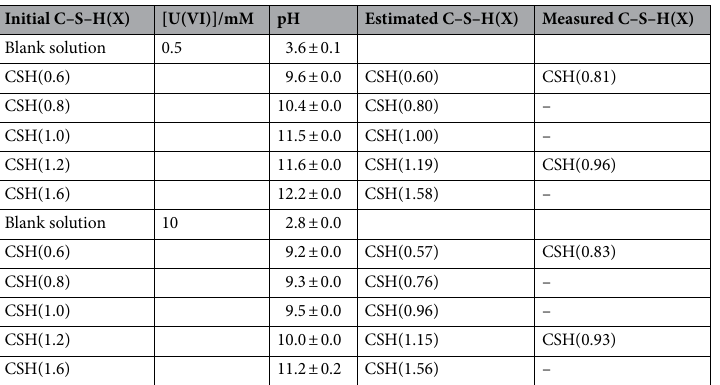
Table 1. pH values of U(VI)-contacted C–S–H solutions after 48 h and final C–S–H composition after contact. Estimated and measured C–S–H compositions are derived from mass balance of solution concentrations present in Fig. 1 and from analysis of 29 Si NMR data shown in Fig. 7, respectively. Errors on pH values represent one standard deviation of triplicate